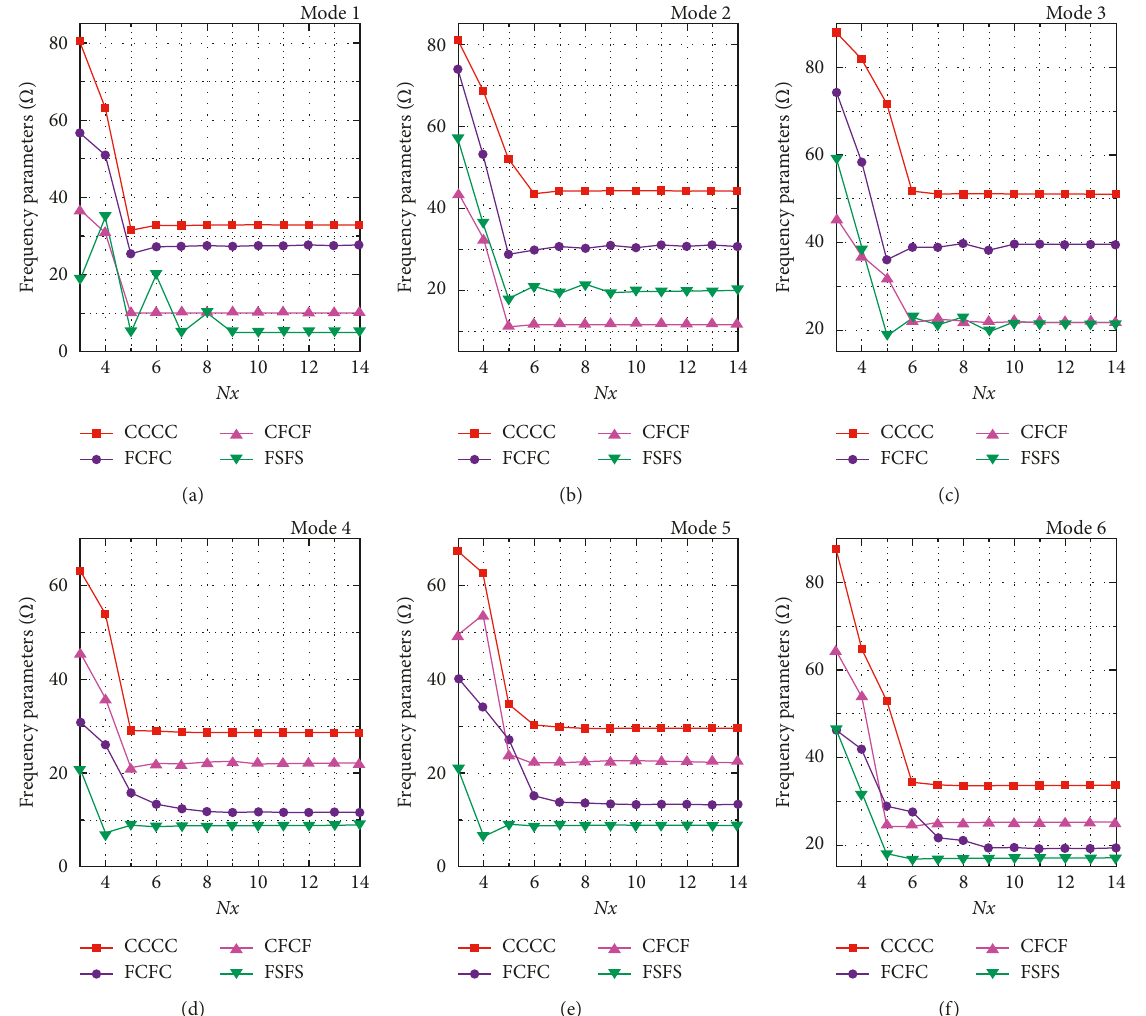
Figure 2: Variation of frequency parameters with various numbers of nodes; (a) axial bulkhead, (b) circumferential